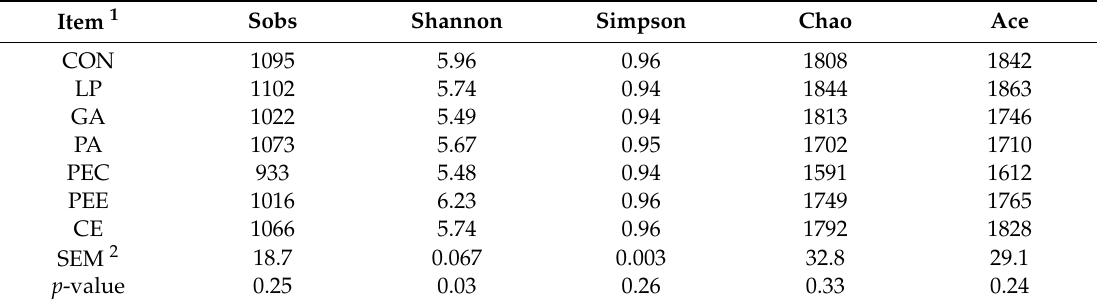
Figure 2. Venn diagram illustrating overlap of microbial operational taxonomic units (OTUs) at 3% dissimilarity level across the treatments.